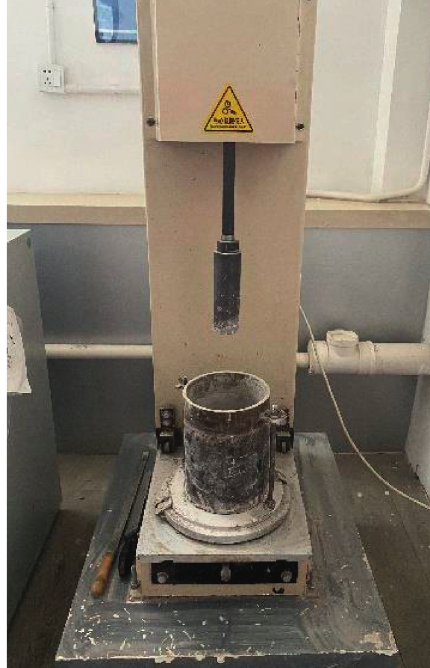
Figure 4: Compaction test